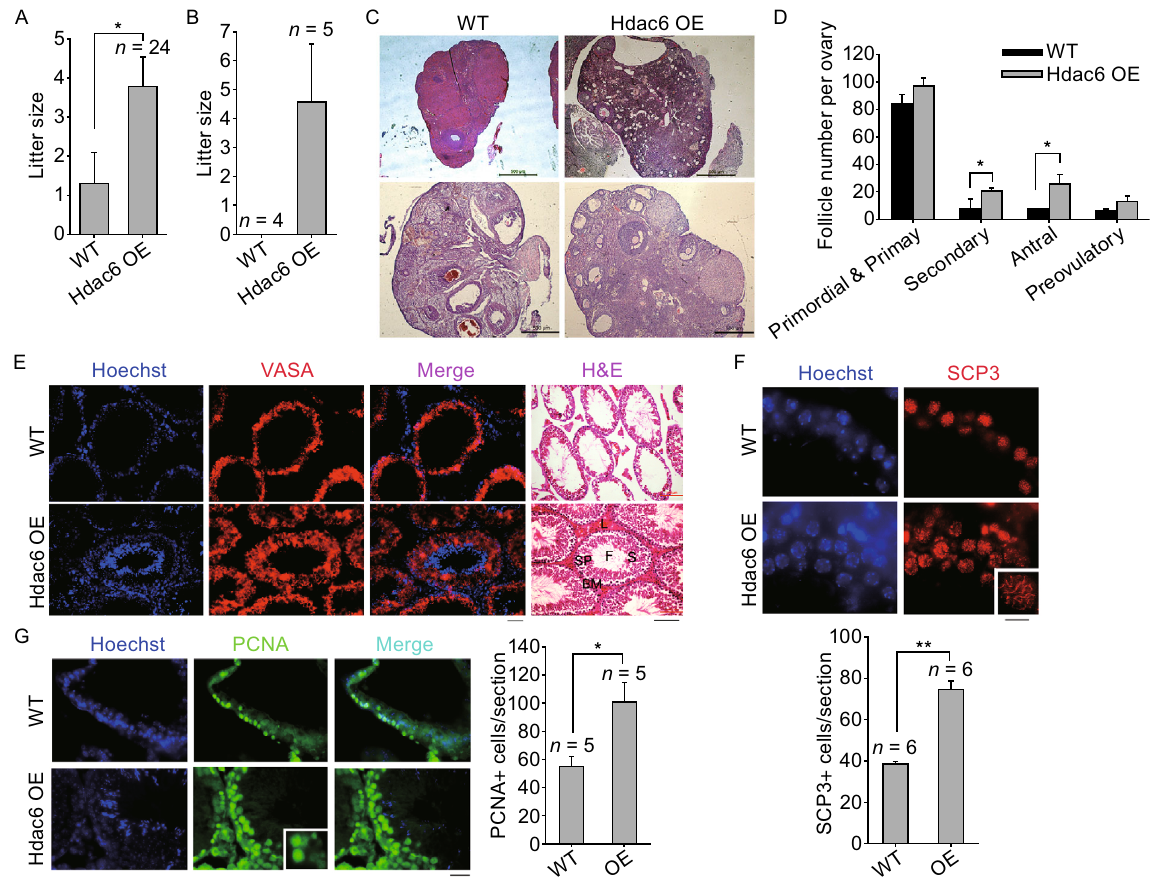
Figure 1. Overexpression of Hdac6 extends reproductive performance . (A – D) Litter size and folliculogenesis in Hdac6 overexpression and WT females. (A) Average litter size based on the number of old (age of 12 to 16 months) B6C3F1 female mice that were successfully mated, showing mating plugs. P < 0.05 by t test. (B) Average litter size produced from successfully mated old (about 10 – 12 months) C57BL/6 inbred females. n = number of successfully mated females. More old C57BL/6 mice were set to mate but failed from plugging. (C) Representative morphology of ovaries by hematoxylin and eosin (H & E) histology. Shown are ovaries from WT at 16-month-old and Hdac6 OE mice at 19-month-old in B6C3F1 hybrid background. Scale bar = 500 μ m. (D) Follicle development at the primordial and primary, secondary, antral, preovulatory stages. * P < 0.05. (E – G) Spermatogenesis and meiosis in old male mice. (E) Robust spermatogenesis in Hdac6 OE mice shown by hematoxylin and eosin (H & E) histology of testis sections and immuno fl uorescence (IF) of VASA, indicative of germ cells, compared with much reduced spermatogenesis in WT mice at B6C3F1 hybrid background. Scale bars for IF = 20 μ m; Scale bars for H & E = 100 μ m. Testis section includes basement membrane (BM), Leydig cells (L), Sertoli cells (S), spermatogonia (SP) and fi lament (F). (F) Early meiocytes showing distinct synaptonemal complex protein-3 (SCP3) lateral fi lament structure at pachytene stage and quanti fi cation of average SCP3 positive cells per seminiferous tubule section. Inset, SCP3 lateral fi laments at higher magni fi cation. (G) Immuno fl uorescence of PCNA in testis from WT and Hdac6 OE males and relative quanti fi cation of average PCNA positive cells per seminiferous tubule section. Scale bar = 20 μ m (SCP3) or 50 μ m (PCNA). * P < 0.05, ** P < 0.01. n = number of tubule sections